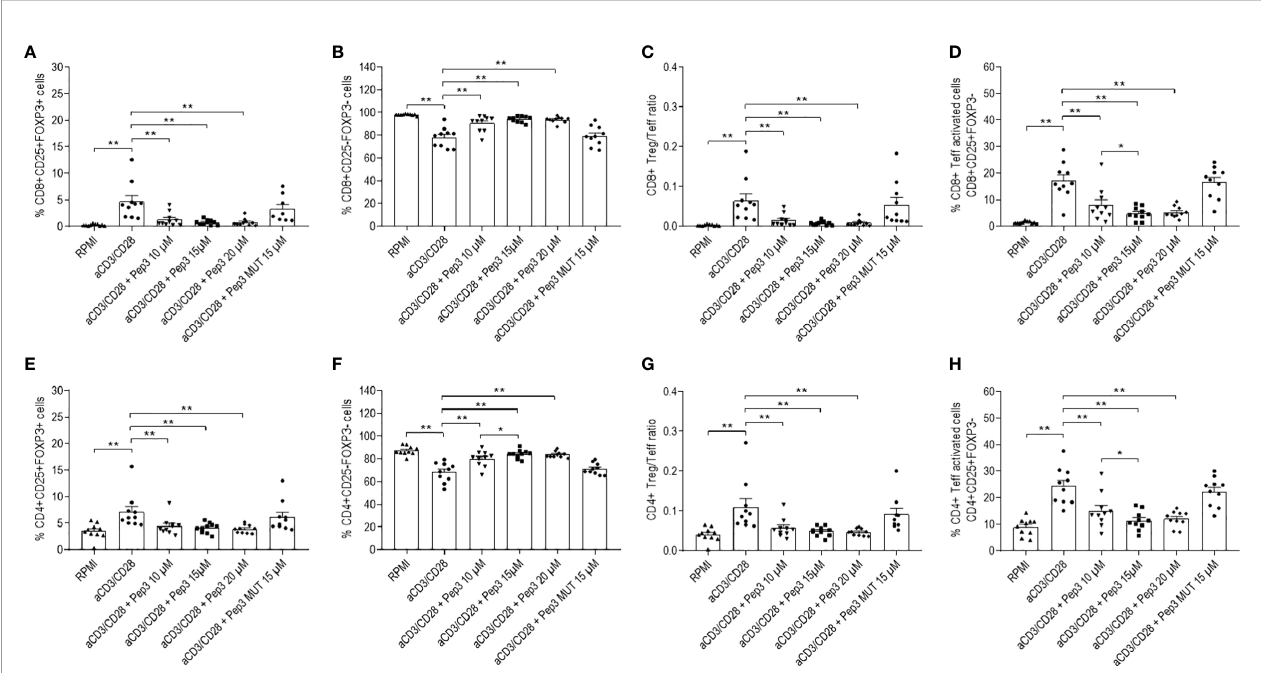
FIGURE 1 | Frequency of T-cell populations in PBMC isolated from TC patients treated with peptide 3 and subsequently stimulated with anti-CD3/CD28 beads for 4 days. Flow-cytometry analysis of TC PBMC untreated unstimulated (RPMI) or stimulated (anti-CD3/CD28), treated with 10, 15, and 20 µM Pep3 or 15 µM of Pep3 MUT and subsequently stimulated with anti-CD3/CD28 beads for 4 days. Percentages of CD8+ subsets (CD8+ Treg, CD8+ Teff, CD8+ Teff activated) were calculated on total CD8+ cells. Percentages of CD4+ subsets (CD4+ Treg, CD4+ Teff, CD4+ Teff activated) were calculated on total CD4+ cells. Percentages of total CD8+ and CD4+ cells were calculated on total lymphocytes. Graphs show the percentages upon CD3/CD28 stimulation of CD8+ Treg as CD8+CD25+FOXP3+ cells (A) , CD8+ Teff as CD8+CD25 − FOXP3 − cells (B) , CD8+ Treg/Teff ratio (C) , CD8+ Teff activated cells as CD8+CD25+FOXP3 − cells (D) , CD4+ Treg as CD4+CD25+FOXP3+ cells (E) , CD4+ Teff as CD4+CD25 − FOXP3 − cells (F) (please refer for gating strategy to S1 Figure ), CD4+ Treg/Teff ratio (G) , percentage of CD4+ Teff activated cells as CD4+CD25+FOXP3 − cells (H) . Statistical signi fi cance was evaluated using Wilcoxon matched-pairs signed rank test. Data are expressed as mean ± SEM, and each dot corresponds to an individual TC patient (n = 10). *p < 0.05, **p <